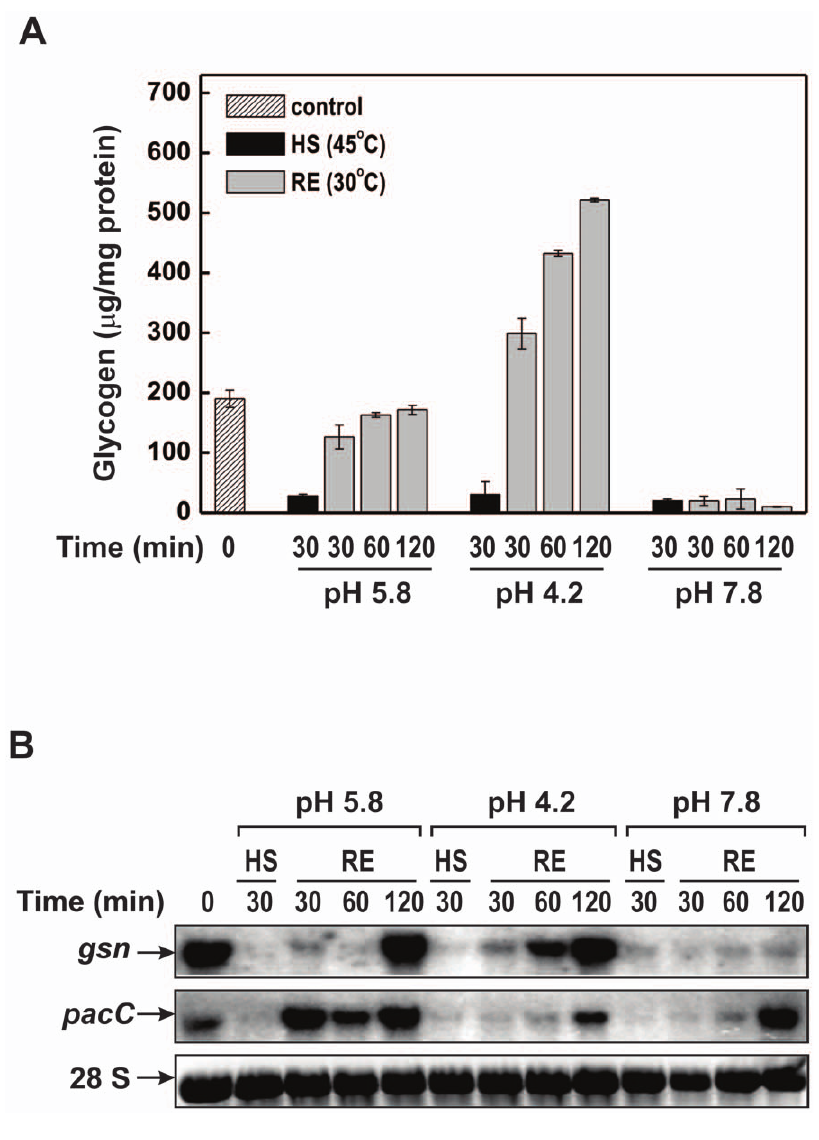
Figure 5. Glycogen accumulation and gene expression during combined pH and heat shock stress. Glycogen and total RNA were extracted from wild-type mycelia cultivated at pH 5.8 and 30 u C for 24 h and then shifted to pH 5.8, 4.2 and 7.8 at 45 u C for 30 min. After 30 min, the remaining samples were transferred back to the physiological temperature (30 u C) at the three pH conditions and incubated for different times (RE, recuperation). (A) Accumulation of glycogen. (B) gsn and pacC gene expression. Total RNA (15 m g) was separated by electrophoresis in a denaturing formaldehyde gel, transferred to nylon membrane and probed with the a - 32 P radiolabeled 678 bp gsn cDNA and 639 bp pacC cDNA fragments (gel autoradiographies). The 28 S rRNA was used as a loading control after ethidium bromide staining. The results shown are the average of at least three independent experiments. 0, cell samples before pH shifting (control).